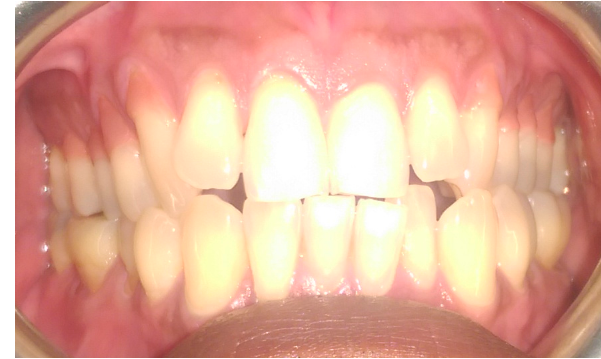
Figure 8. Post operative view at 11 months.